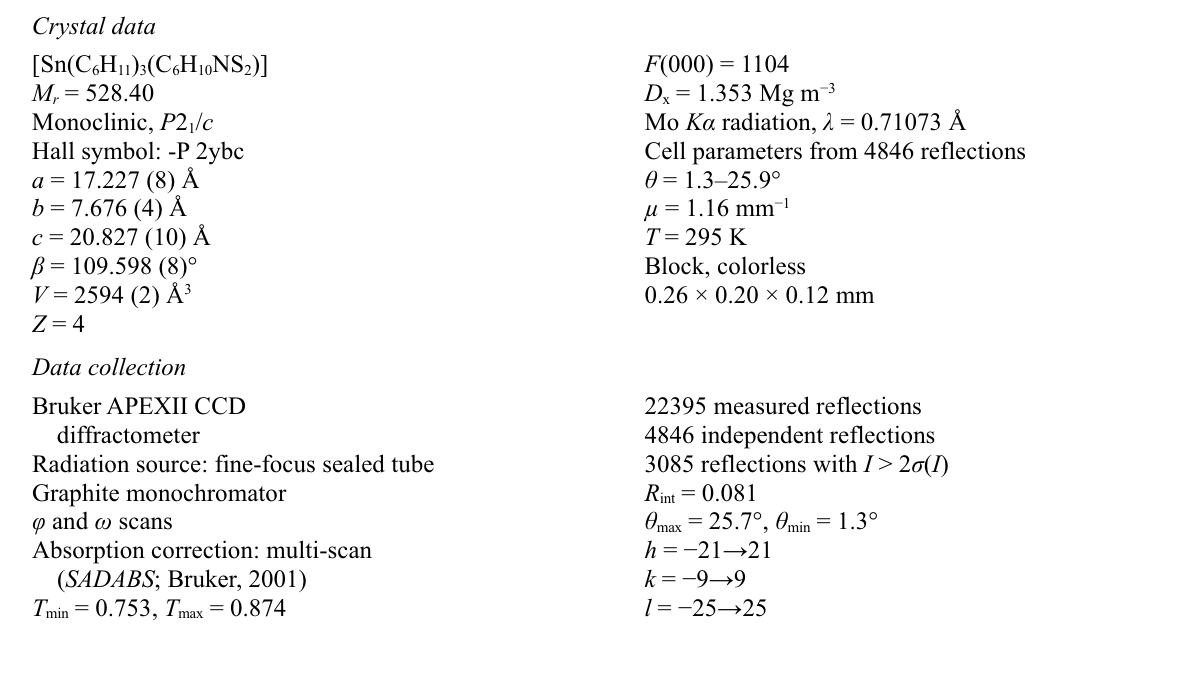
The molecular structure of the title compound, with 30% probability displacement ellipsoids for the non-H atoms. Tricyclohexyl(piperidine-1-dithiocarboxylato- κ